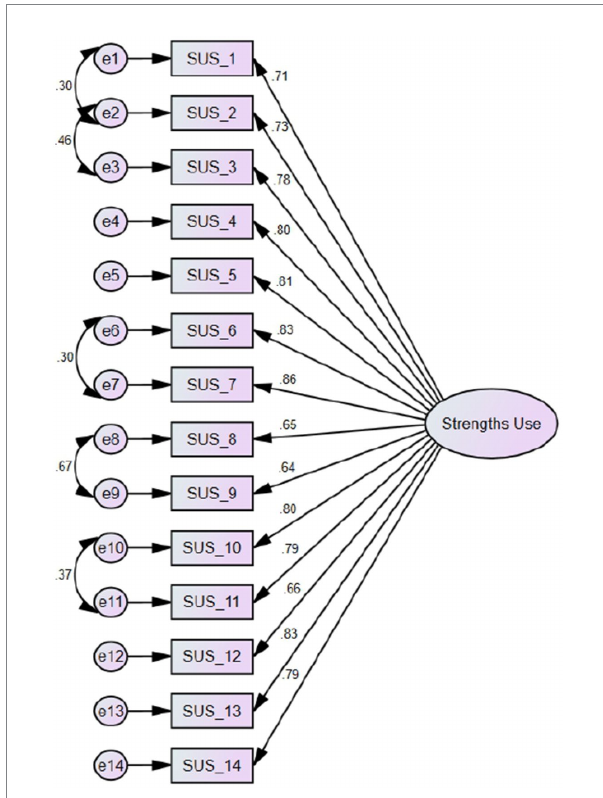
FIGURE 1 Factorial Structure of the Spanish version of the strengths Use scale (Study